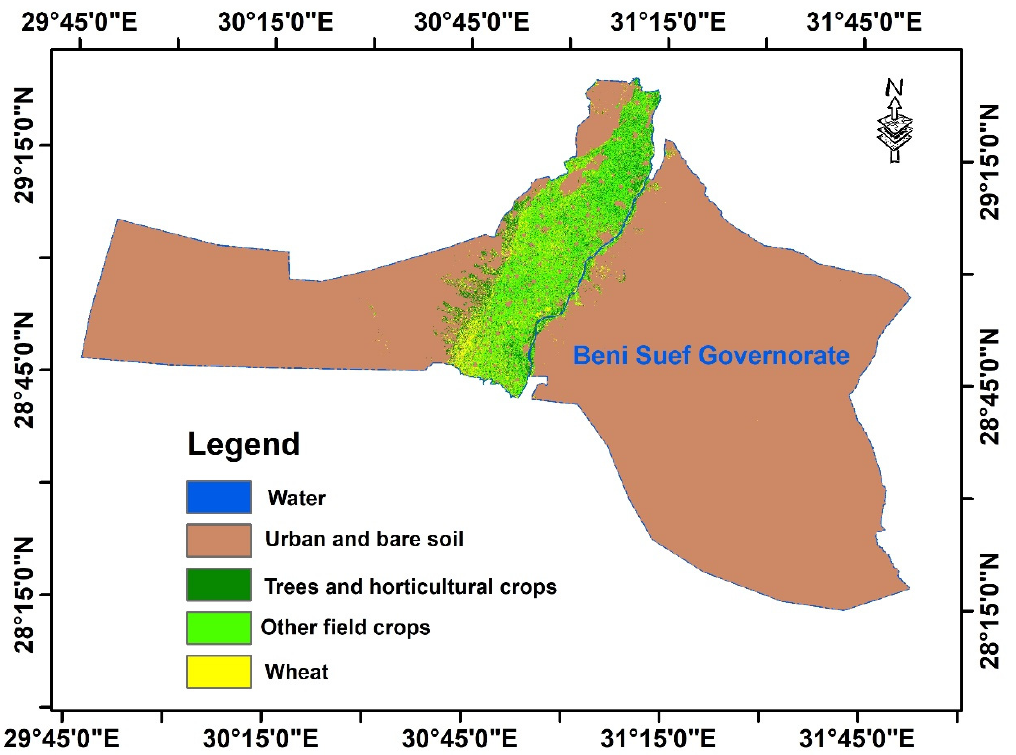
Figure 12. The classified land use and cover classes include major field crops, water streams, urban areas, bare soil, trees, horticultural crops, other winter crops, and wheat.